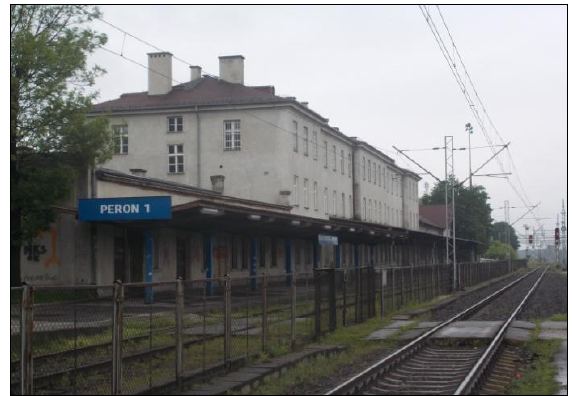
Fig. 5. The railway station in Szczakowa in 2014 ( W. Dragan